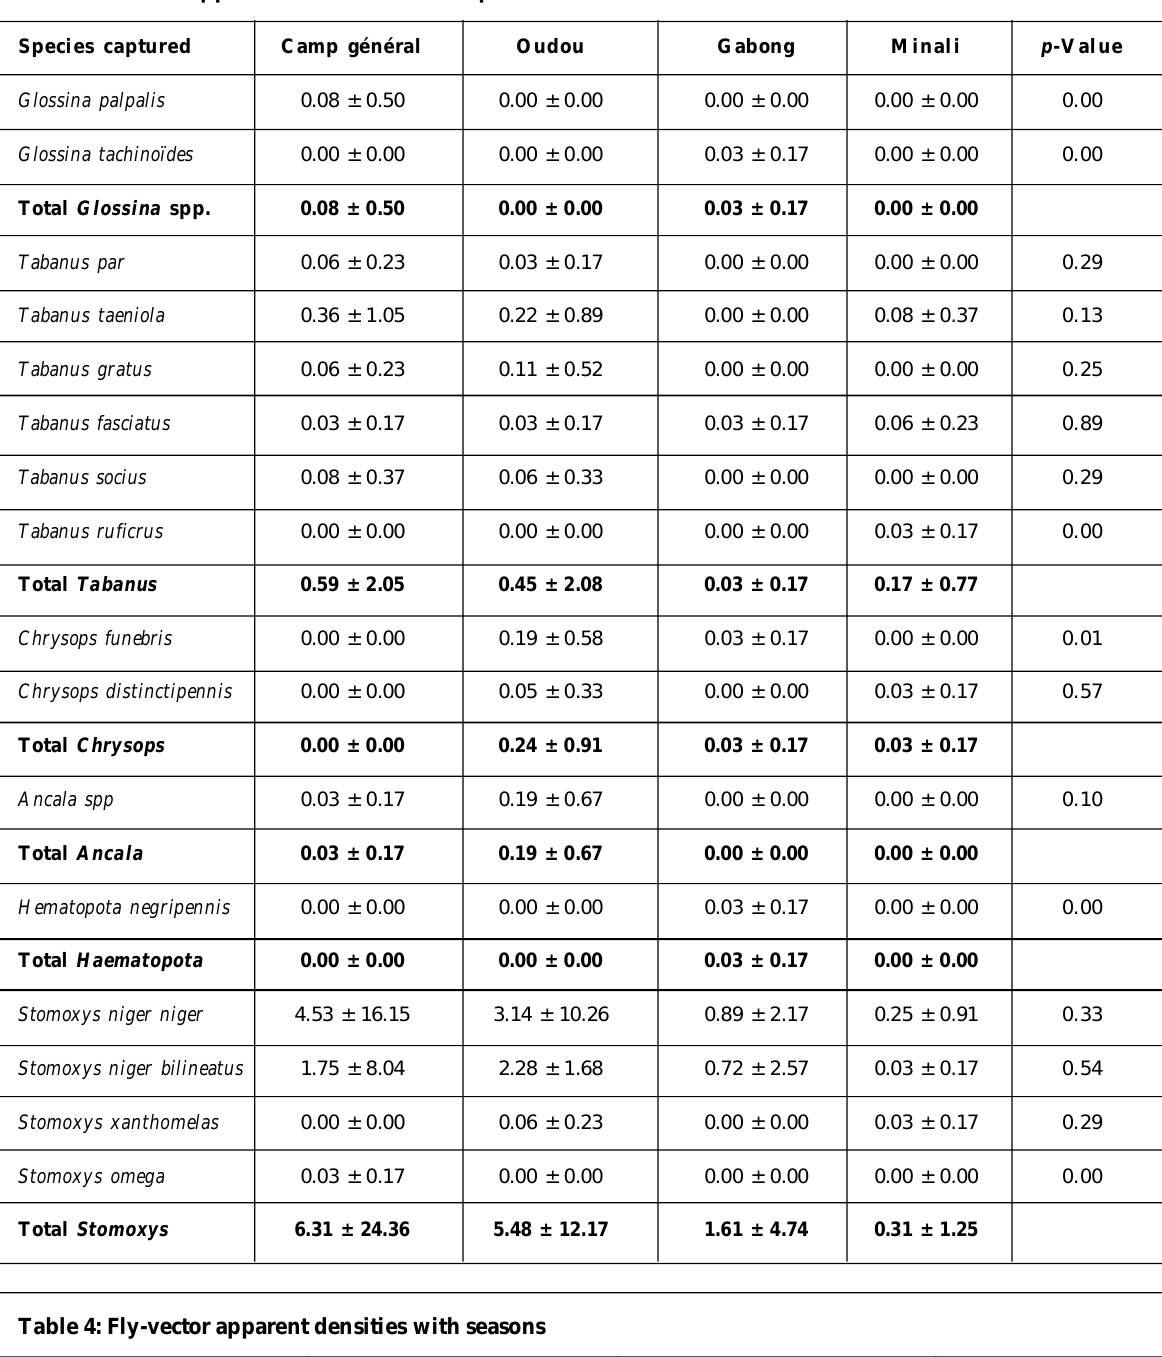
Table 3: Vectors apparent densities with sampled sites